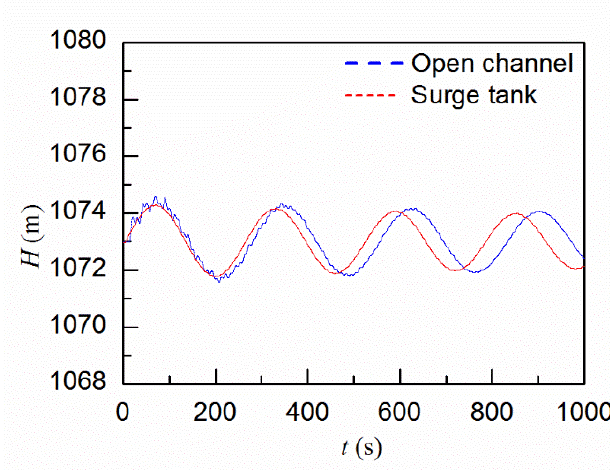
Figure 13. Comparison of the water levels in the sand basin with different modelling methods ( L 1 = 400 m, h = 10 m, w = 10 m).